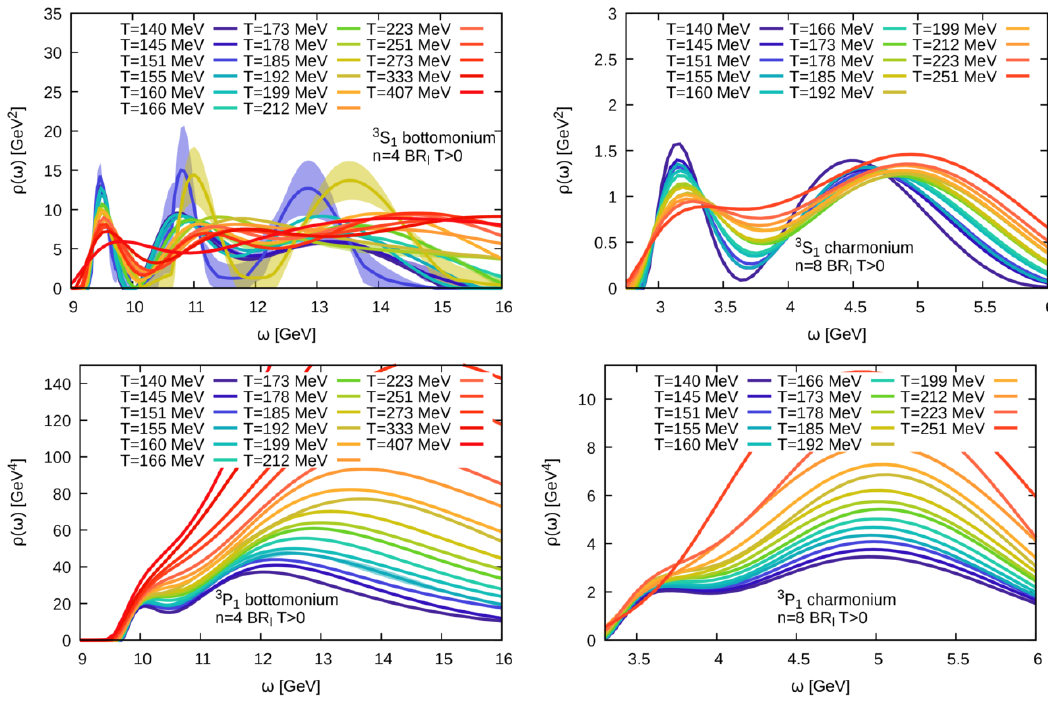
Figure 20 . Finite temperature bottomonium (left) and charmonium (right) spectral functions reconstructed using the smooth BR method. The top row contains the spectral functions in the 3 S 1 channel, while the bottom row features the